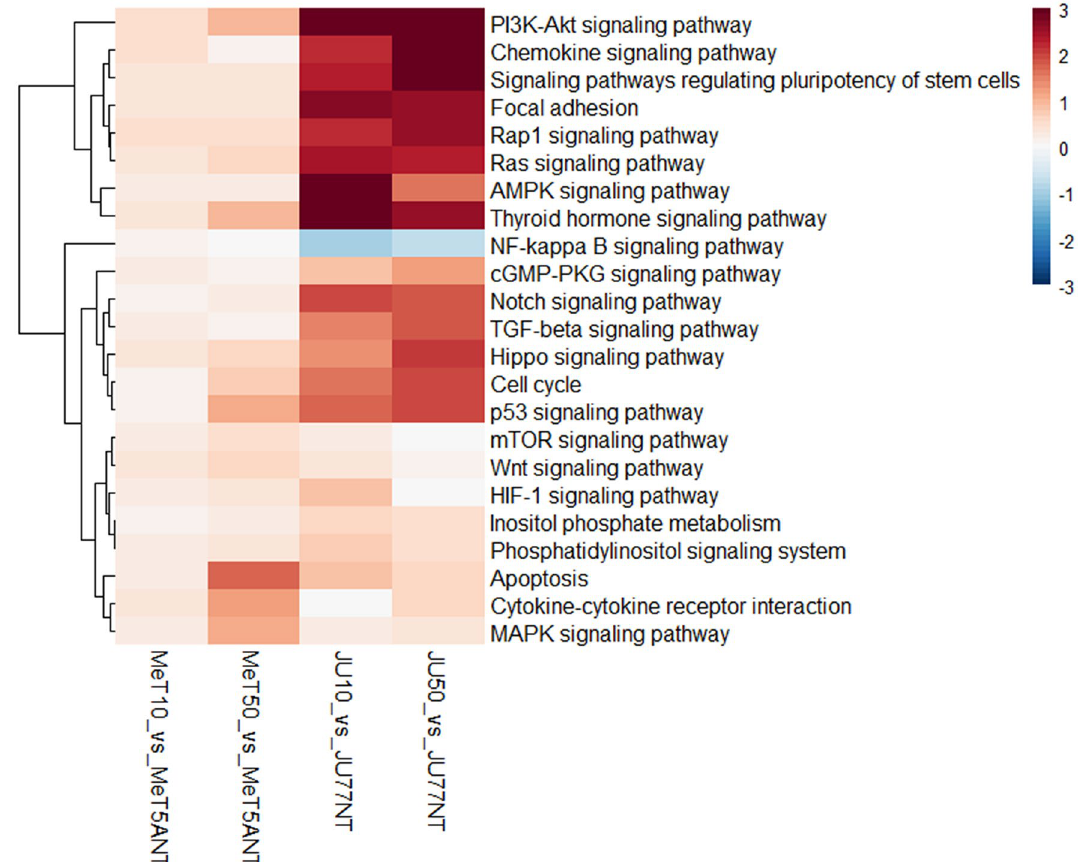
Figure 6. Heatmap showing the dysregulated pathways between untreated vs. FE fibers treated JU77 (human malignant mesothelioma) and MeT-5A (human normal mesothelium) by taking into account the differentially expressed